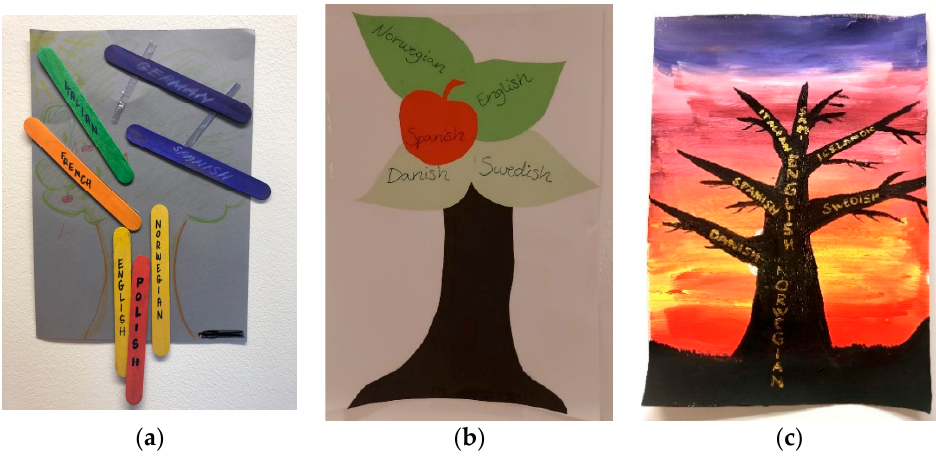
Figure 3. ST1’s ( a ), ST2’s ( b ), and ST3’s ( c ) DLC artefacts.